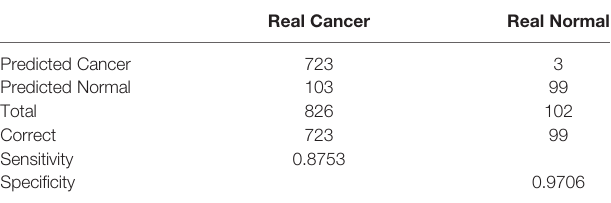
TABLE 2 | Sensitivity and speci fi city of diagnosis